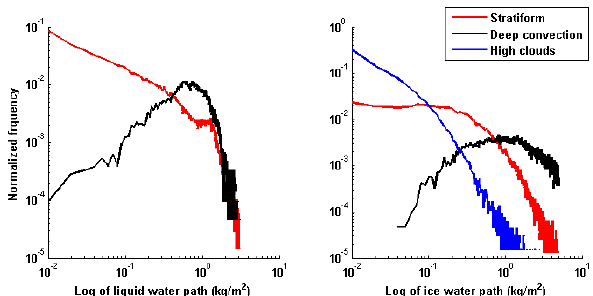
Figure 5. Probability density functions of liquid and ice water paths for the selected cloud types and for the summer monsoon months (JJAS) based on CloudSat’s 2B-CWC-RVOD and 2B-CLDCLASS- LIDAR